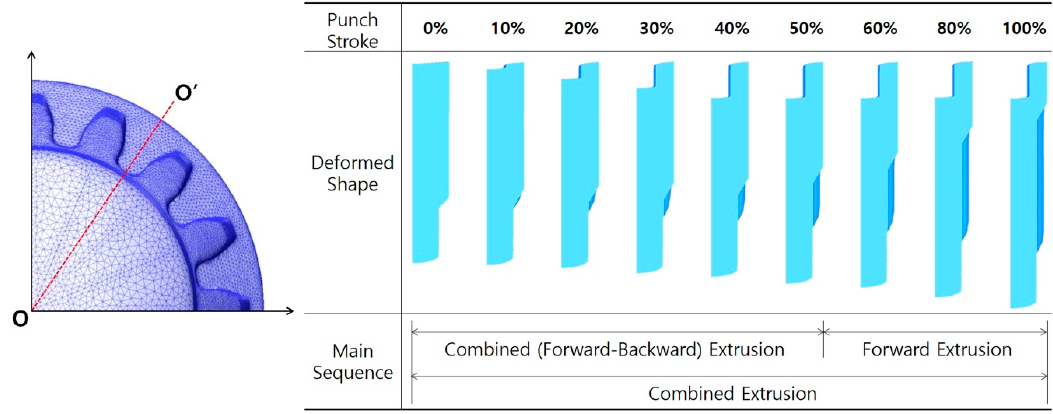
Figure 12. Deformation history and operation sequence of the combined extrusion for the drive shaft.